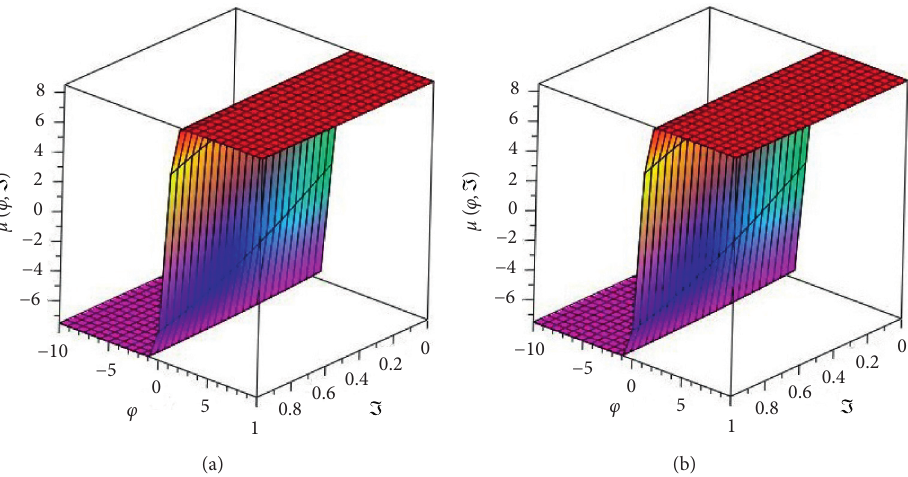
Figure 5: The exact and analytical solution with respect to the Atangana–Baleanu operator of μ ( φ , I ) at β � 1 of Example 3.